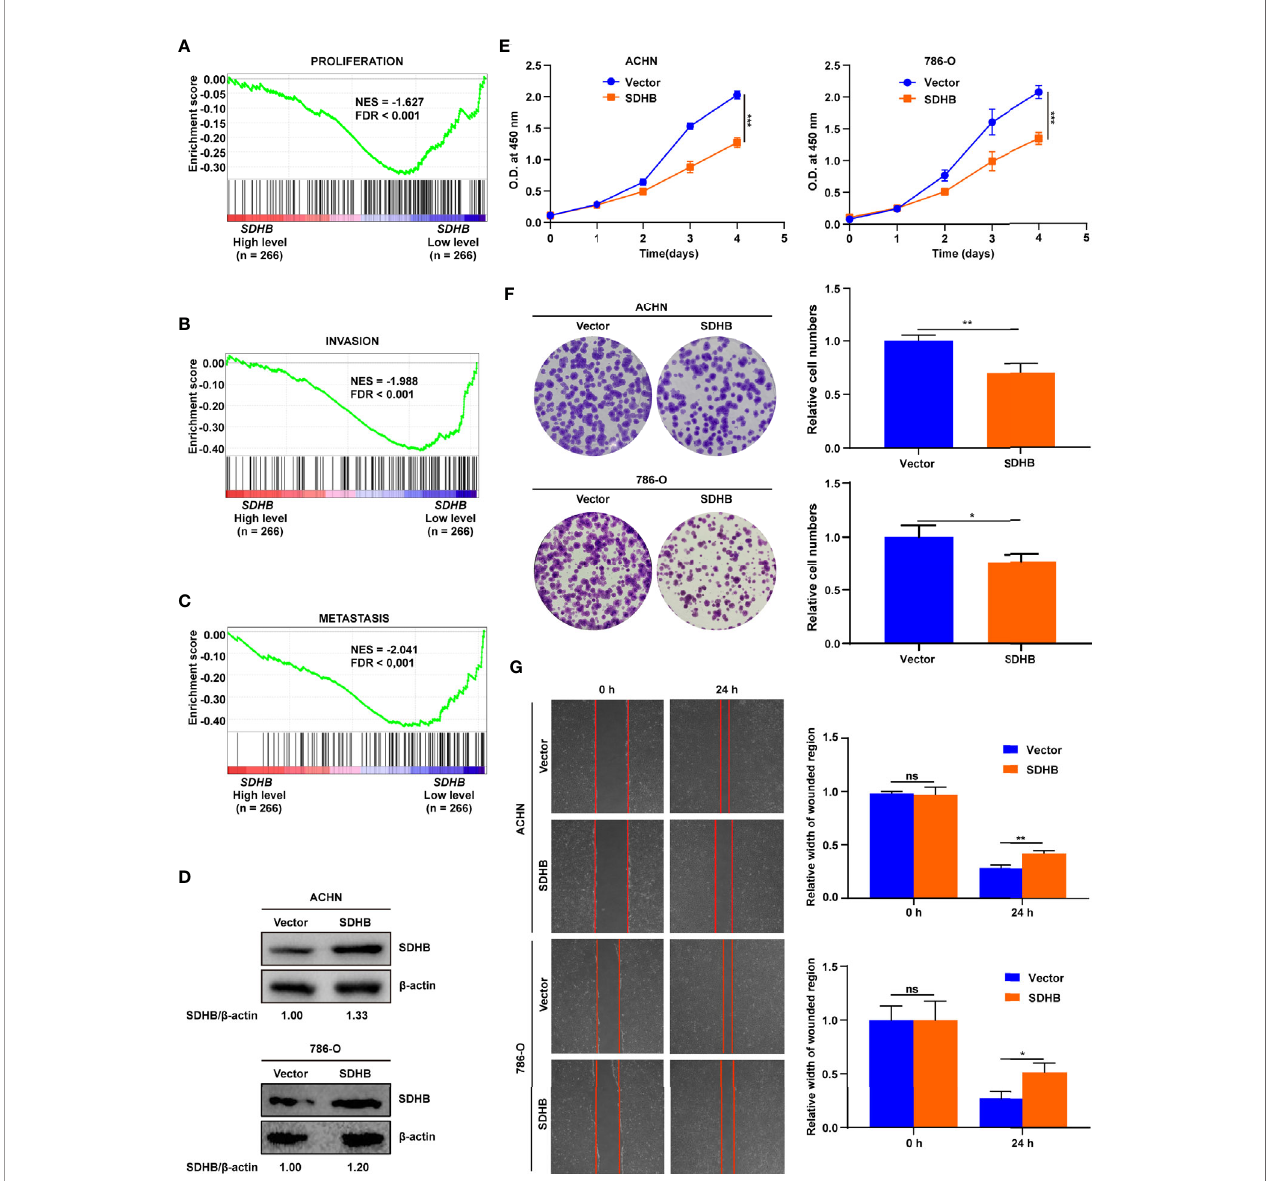
FIGURE 4 | SDHB suppresses ccRCC cell proliferation and migration. (A – C) Enrichment plots of gene expression signature for proliferation (CHIANG_LIVER_ CANCER_SUBCLASS_PROLIFERATION_UP), invasion (PUIFFE_INVASION_ INHIBITED_BY_ASCITES_DN), metastasis (VANTVEER_BREAST_CANCER_ METASTASIS_DN) were obtained by GSEA according to SDHB mRNA levels. The ccRCC samples from TCGA_KIRC database were divided into high and low SDHB expression groups according to the median value of SDHB RNA-seq quanti fi cation results. (D) Western blotting results showed that SDHB was highly expressed in ccRCC cell lines following transfection with SDHB expression plasmid compared with control vector. b -actin was used as a loading control. (E) SDHB overexpression signi fi cantly suppressed ACHN and 786-O cell proliferation by CCK8 viability analysis. (F) SDHB overexpression signi fi cantly suppressed ACHN and 786-O cell colony formation by plate colony formation assay. (G) SDHB suppressed cell migration by wound healing assay. The relative migration distance is quanti fi ed. The data were presented as mean ± SD. P value was derived from repeated-measures ANOVA (E) and independent sample two tailed t -test (F, G) . ** P < 0.01; *** P < 0.001. The data in (D – G) are representative of three independent experiments. * P < 0.05; ns, no signi fi